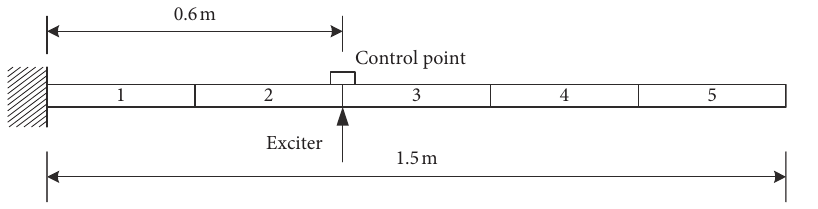
Figure 6: Diagram of the simulated cantilever beam. Table 1: Parameter setting for reference spectrum.